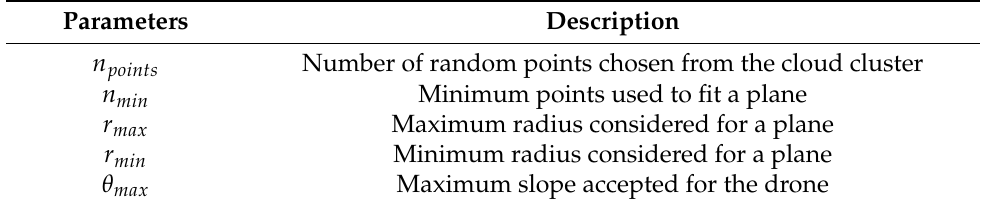
Table 1. The parameters used in the plane detection